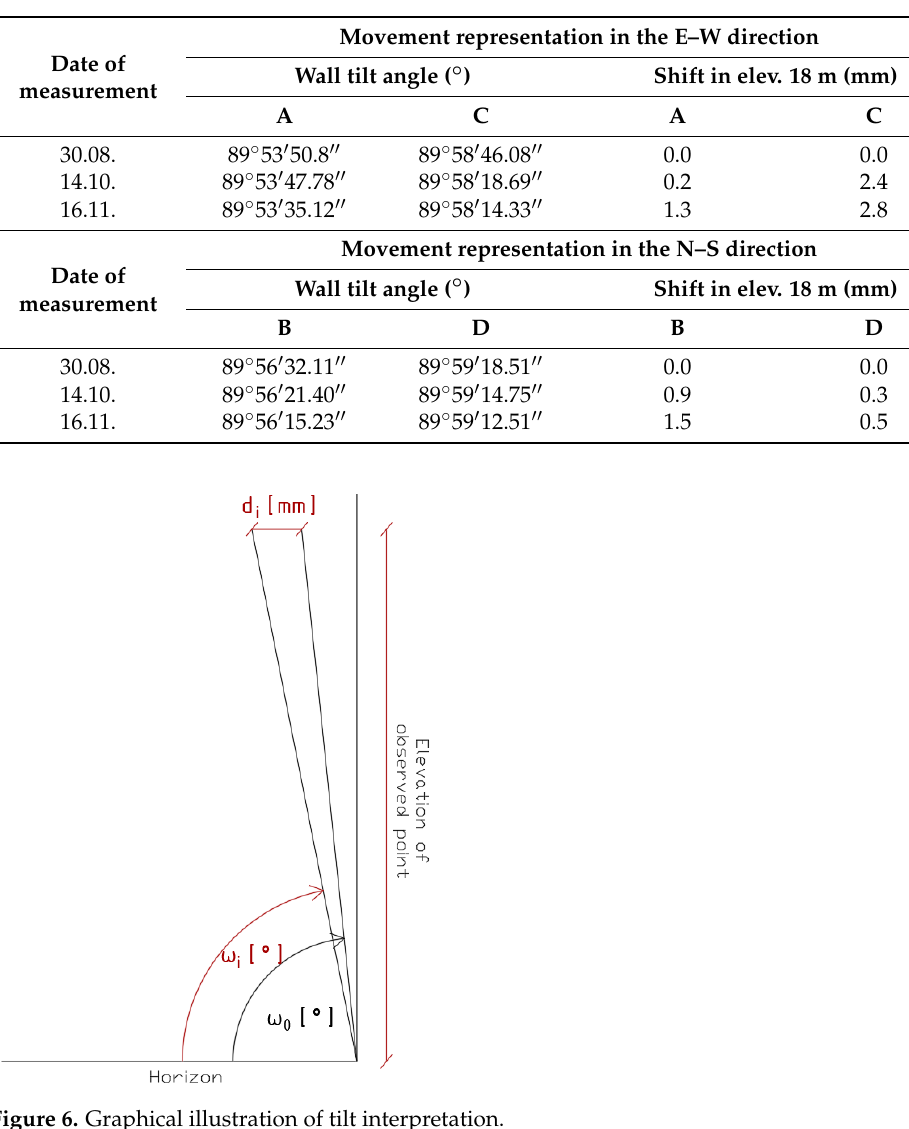
Table 2. Various ways of tilt interpretation.